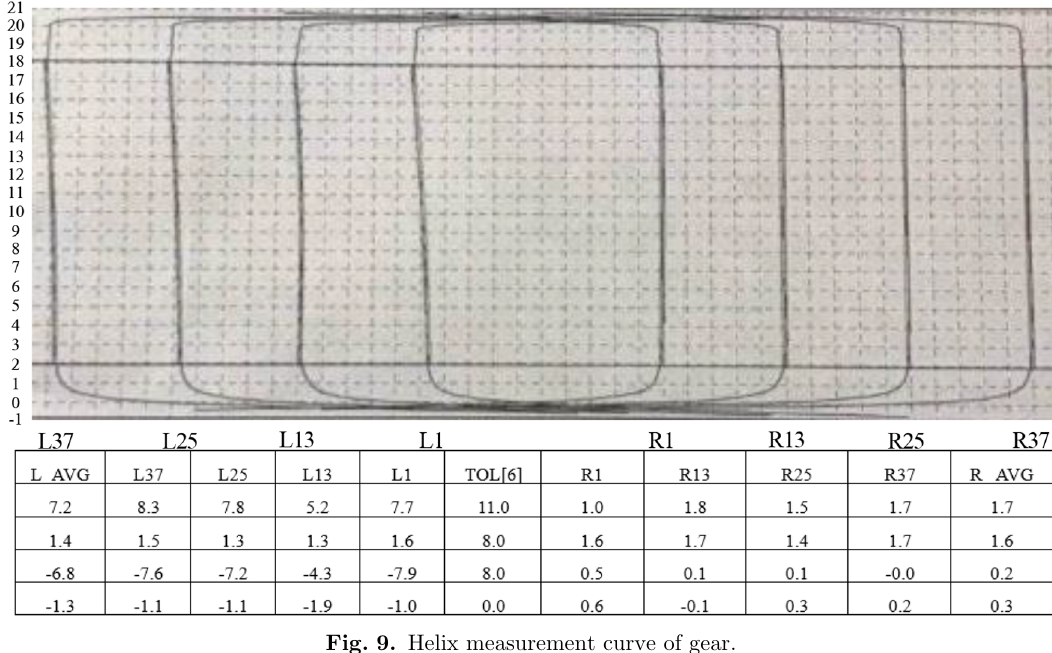
Fig. 9. Helix measurement curve of gear.